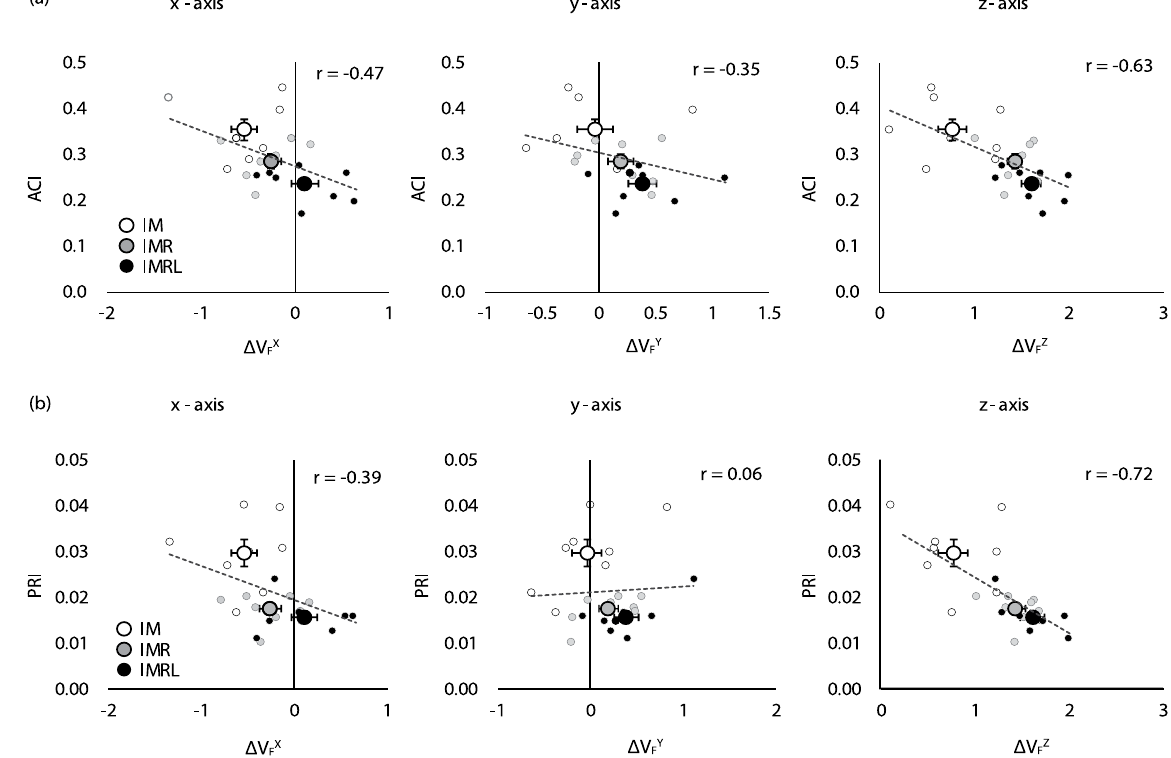
Figure 5. Correlation between the synergy indices of F TOT stabilization for three axes (i.e., Δ V FX , Δ V FY , and Δ V FZ ) and ( a ) accuracy index (ACI) and ( b ) precision index (PRI). Small dots represent individual subject data for the IM (white), IMR (gray), and IMRL (black) conditions. The regression lines are shown with the coefficient of determination ( r -value). The average values across subjects for the IM (white), IMR (gray), and IMRL (black) condition are presented with standard error bars in large